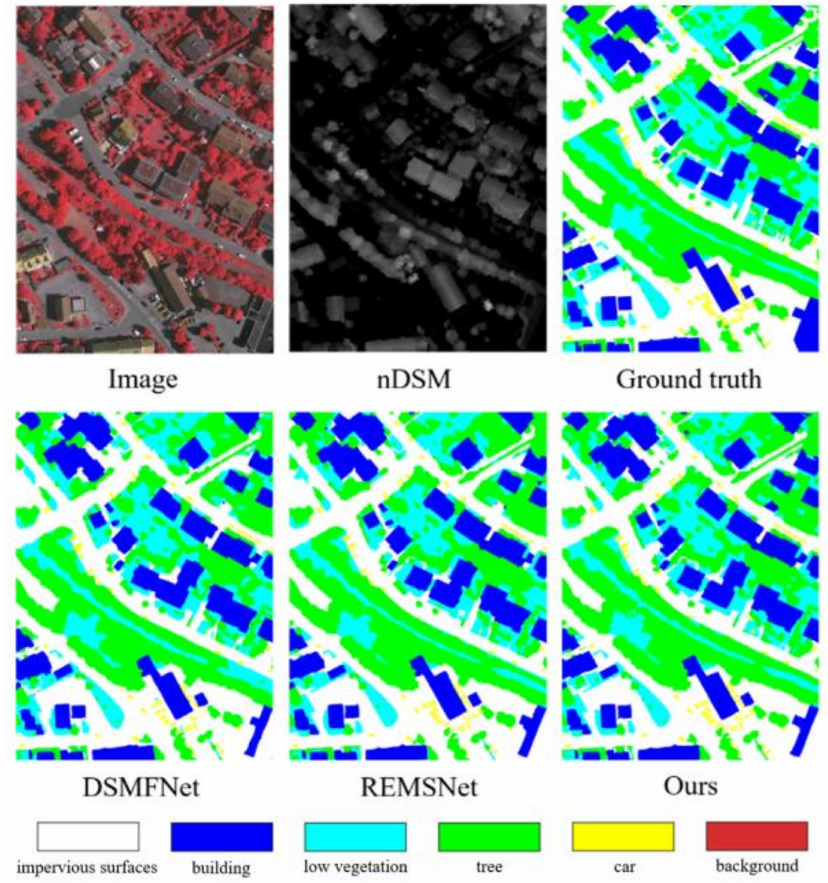
Figure 10. The results of MMAFNet on the Vaihingen dataset are shown and compared.